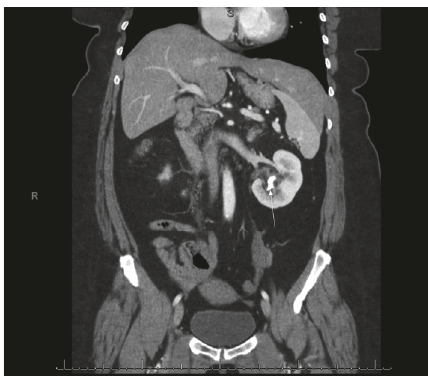
Figure 2: Coronal CT scan of the abdomen and pelvis with contrast revealed a 6 mm obstructing right proximal ureteral stone (not shown in image) causing mild hydronephrosis and a 2 cm left inferior pole staghorn calculus causing calyceal dilatation